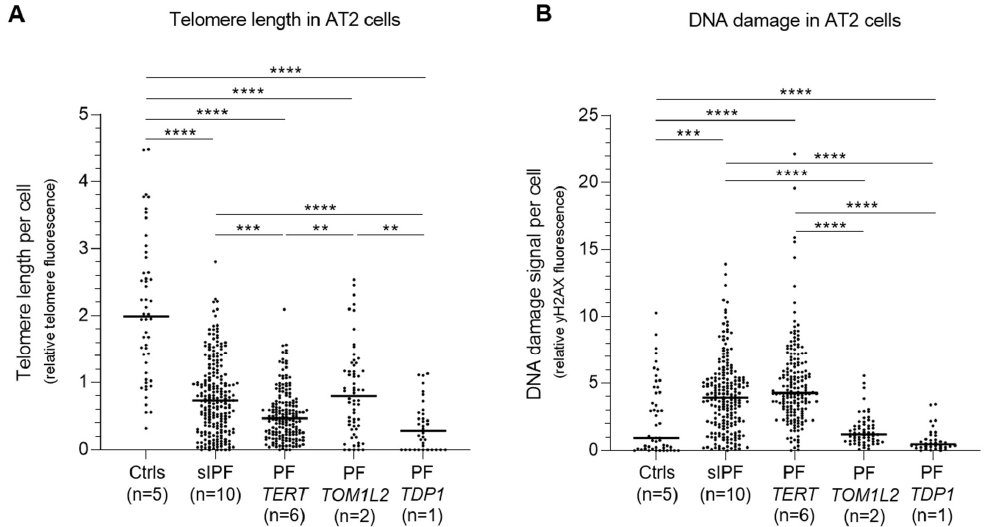
Figure 8. Cell specific quantification of telomere length (A) and DNA damage (B) in alveolar type 2 (AT2) cells of control, sporadic IPF (sIPF) and pulmonary fibrosis with a mutation in TERT or variant in TOM1L2 or TDP1 . Telomere length is measured by FISH and DNA damage by immunofluorescence for γH2AX. **: p < 0.01; ***: p < 0.001; ****: p < 0.0001, calculated by Kruskal–Wallis multiple comparison tests and Dunn’s multiple comparison test.